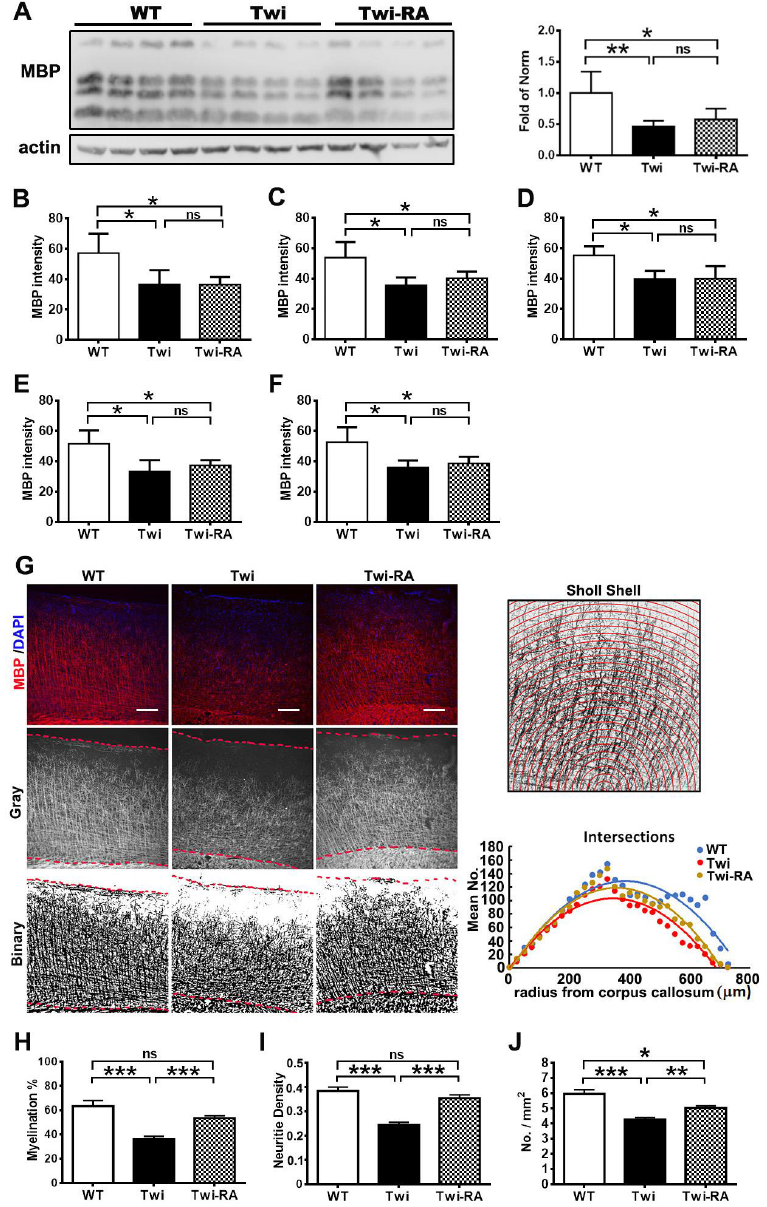
Figure 7. Rapamycin preserves myelin architecture. ( A ) Western blot analysis of MBP expression in brain stem of wild-type (WT), untreated twitcher (Twi), and rapamycin-treated twitcher (RM) mice brains at ages 35 days. Band intensities were measured by densitometry, normalized to actin expression, and are relative to wild-type mice. Values are expressed as mean ± SD and compared using One way ANOVA (Tukey post hoc test). ( n = 4). The brain was immuno-stained with anti-MBP. Myelination of MBP fluorescence intensity in corpus callosum ( B ), thalamus ( C ), cerebellum ( D ), brain stem ( E ), and spinal cord ( F ) was quantitatively analyzed with ImageJ. Cortical myelination (dash area) was quantitatively analyzed with ImageJ. ( G ) Illustration of cortical myelination in MBP fluorescence (red), gray, and binary images, respectively. The proportion of myelination ( H ) and neuritis density ( I ) in field of cortex were quantified by measuring the MBP gray value and binary images, respectively. Microstructure complexity of cortical myelination was assessed by Sholl analysis and the numbers of intersections for concentric circles was plotted ( G ) and summed ( J ) for comparison. Values are expressed as mean ± SEM and compared using One way ANOVA (Tukey post hoc test) ( n = 5). Statistical significance, * p < 0.05, ** p < 0.01, *** p < 0.001, and ns (not significant). Scale bar: 200 µ